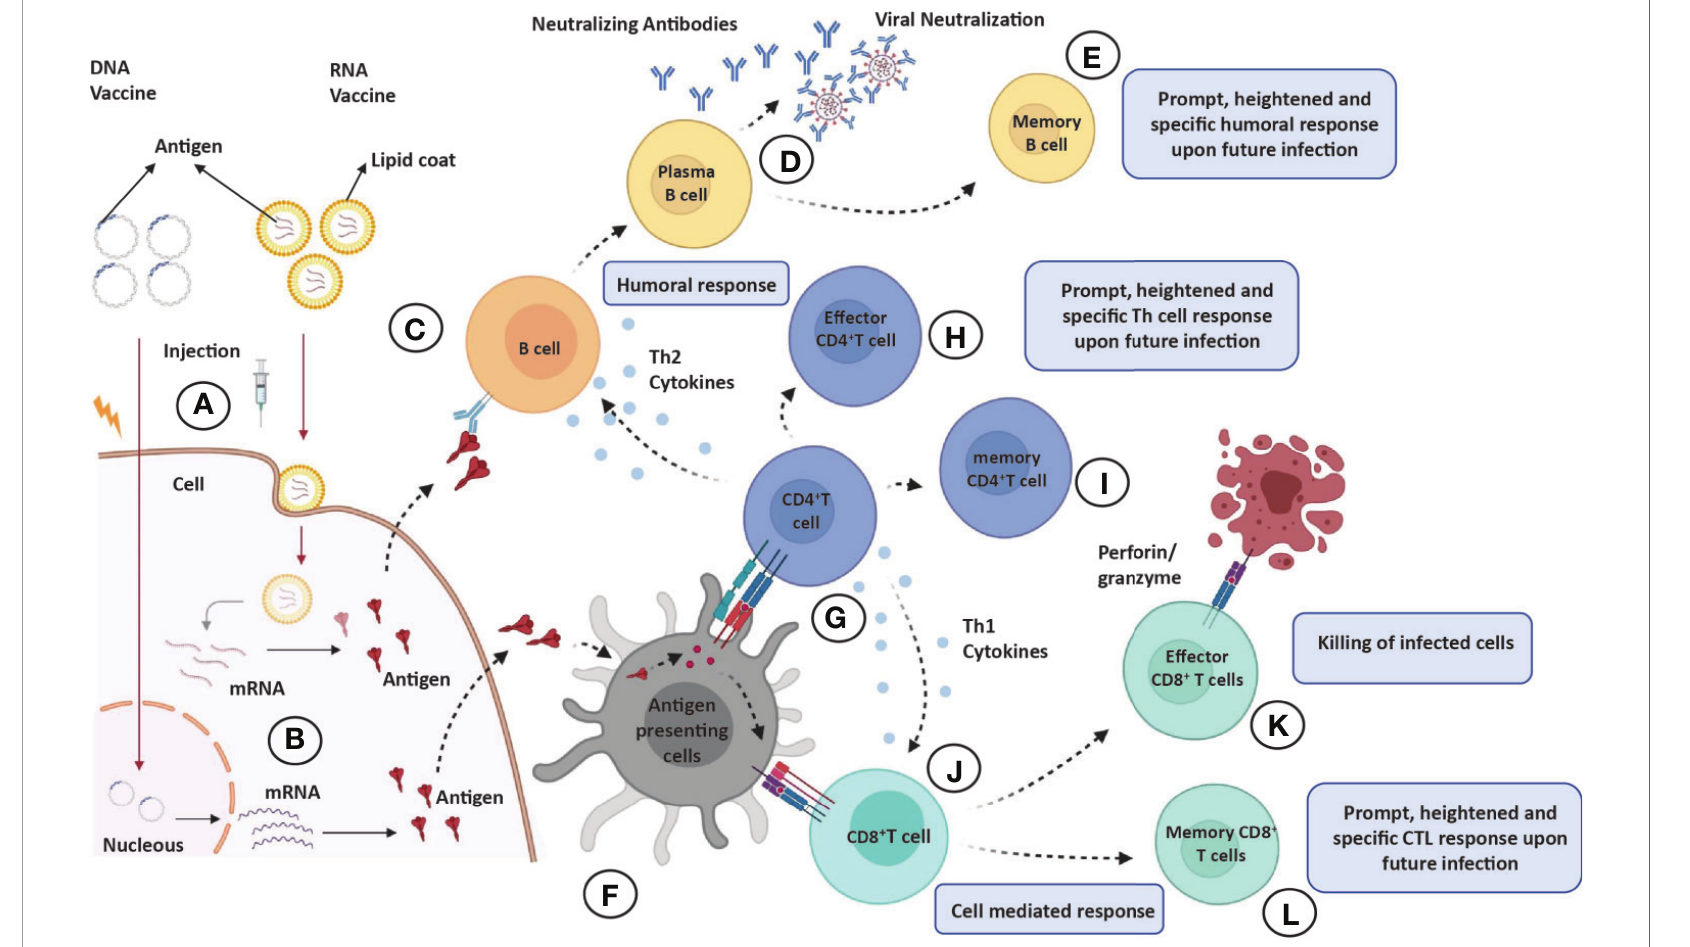
FIGURE 4 | Overview of immune response elicited by various vaccine candidates. When administered into skin or muscle cells (A) , the nucleic acid expresses and codes for an immunogenic protein that mimics viral infection (B) . (C – E) Humoral responses: Antigens produced by skin/muscle cells are released in blood to activate the antibody response; antigen recognition by naïve B cells (C) leading to clonal selection and plasma cell (antibody secreting B cells) formation (D) and eventually production of long-lasting memory B cells (E) . (F) Antigen processing and presentation: The antigen produced by skin/muscle cells are captured by antigen-presenting cells (APCs; dendritic cells or macrophages) for processing and presented by MHC-II or MHC-I molecules on their surface. (G – I) CD4 + T helper cells effector and memory response: The presented MHC-II molecule and antigen complex on APCs recognized by TCR and CD4 molecules on CD4 + Th cells (G) leading to production of effector CD4 + Th cells (H) , which produce suf fi cient levels of cytokines (Th2 cells produce TH2 cytokines IL-4 or IL-10 for humoral response and Th1 cells produce IL-12, IFN-Y for CTL response), and eventually, long-lasting memory CD4 + cells are generated (I) . (J – L) CD8 + T helper cells effector and memory response: The presented antigen and MHC-II molecule complex on APCs recognized by TCR and CD8 molecules on CD8 + T cells (J) leading to production of effector CD8 + T cells also known as cytotoxic T lymphocytes (CTL), which are responsible for killing the infected or self-altered cells (K) , and fi nally, long-lasting memory CD8 + T cells are generated (L) . All memory cells provide long- lasting, heightened, and antigen-speci fi c responses upon future